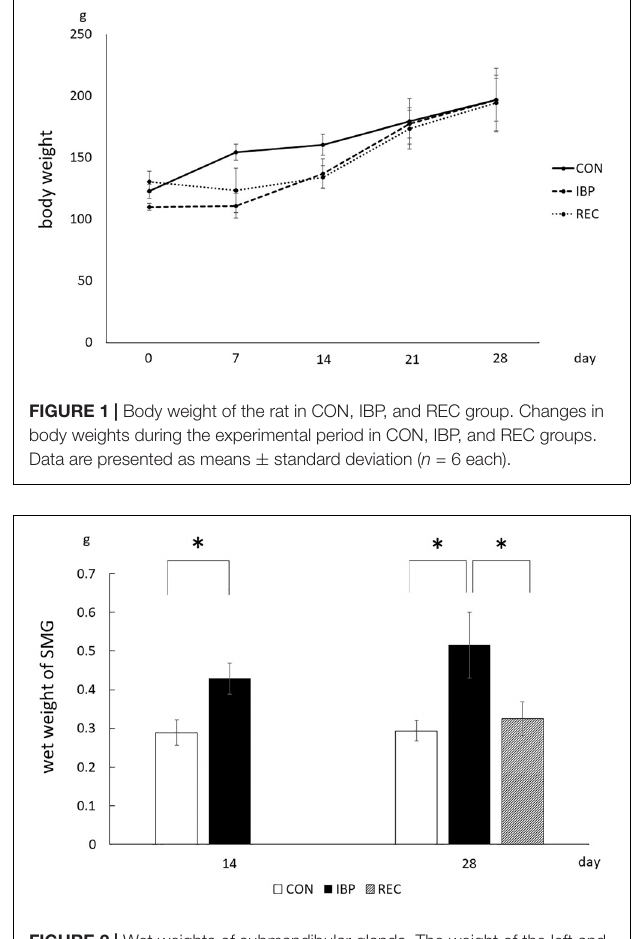
FIGURE 2 | Wet weights of submandibular glands. The weight of the left and right submandibular glands of each rat was measured, and the average value was taken. The weight in the REC group was not significantly different from that in the CON group, whereas it was significantly increased in the IBP group. ∗ p < 0.05.